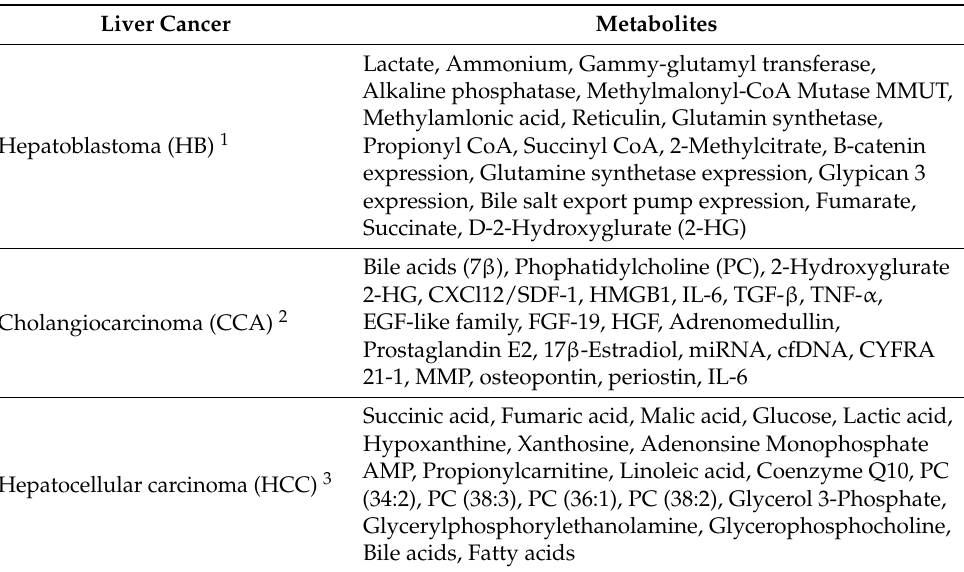
Table 2. Metabolites indicated via metabolomics for liver cancers. Liver Cancer